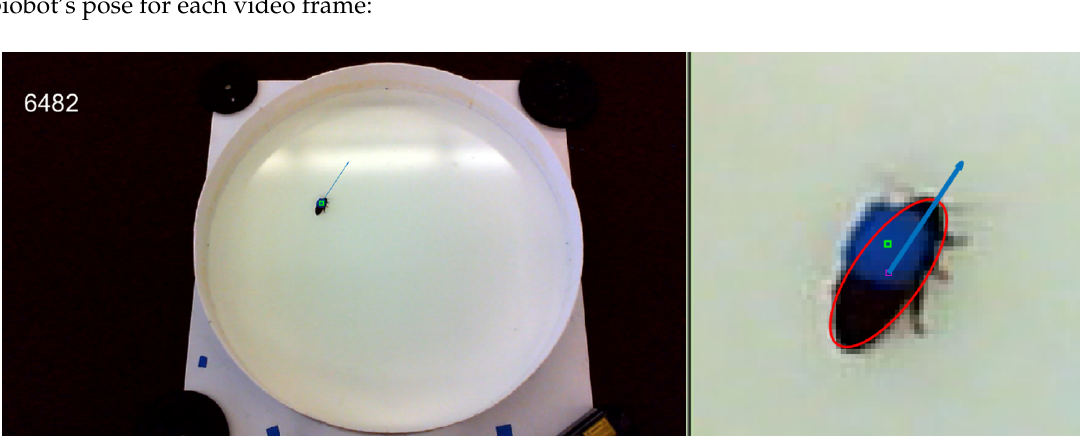
Figure 9. Video Tracker Output: Left Image : Biobotic agent inside the arena. The video frame number is shown in the upper left corner of the image. The center of the IMU is marked as a green square and the heading of the biobot is shown with a blue arrow. Right Image : Close-up shot of the biobot. The green square denotes the center of the IMU and the blue arrow denotes the biobot’s heading. Additionally, the contour of the biobot’s body is highlighted with a red ellipse and the center of the biobot’s body is marked with a magenta square. All of the aforementioned elements were obtained using the computer vision algorithm described in Section